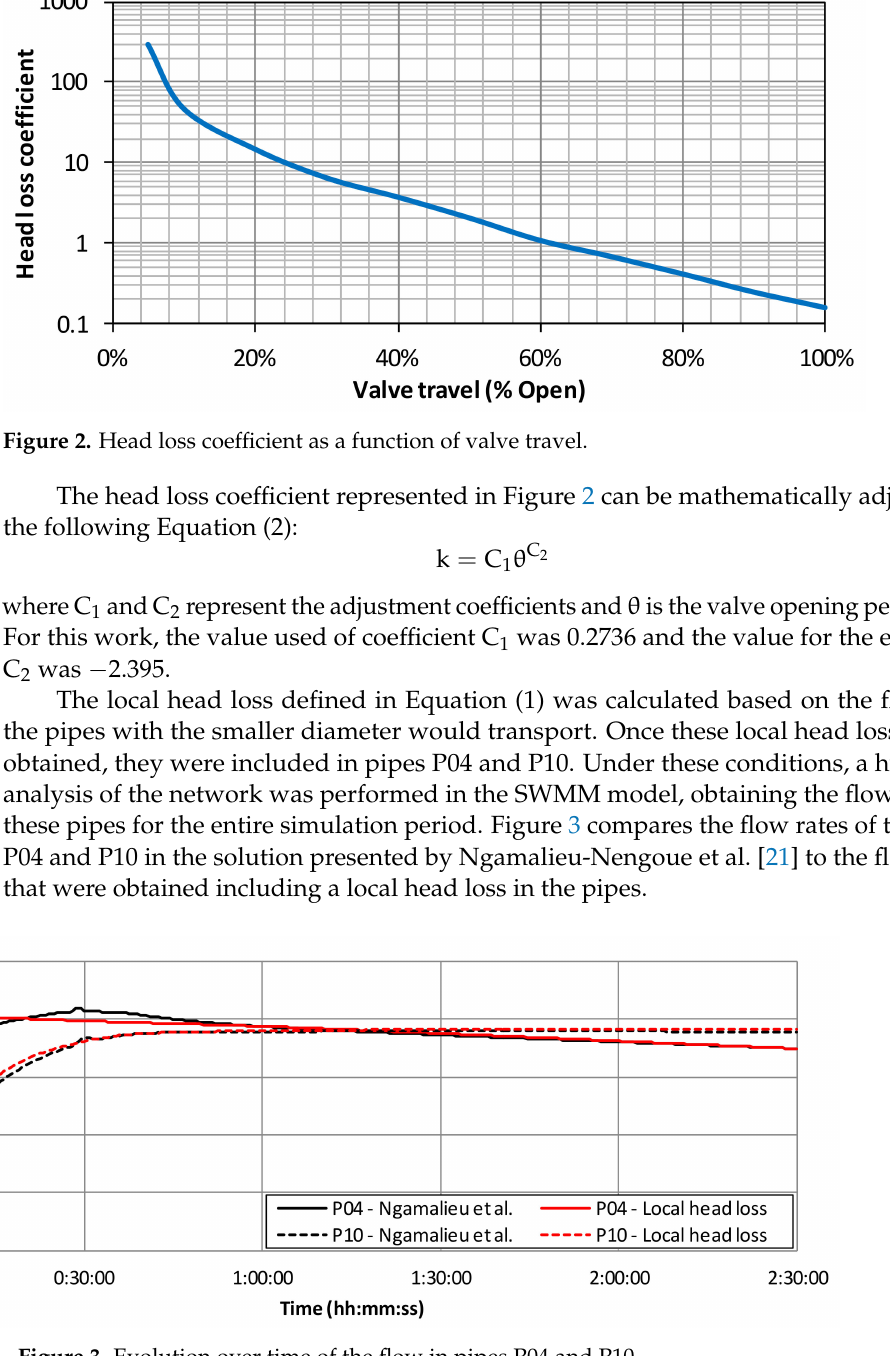
Figure 3. Evolution over time of the flow in pipes P04 and